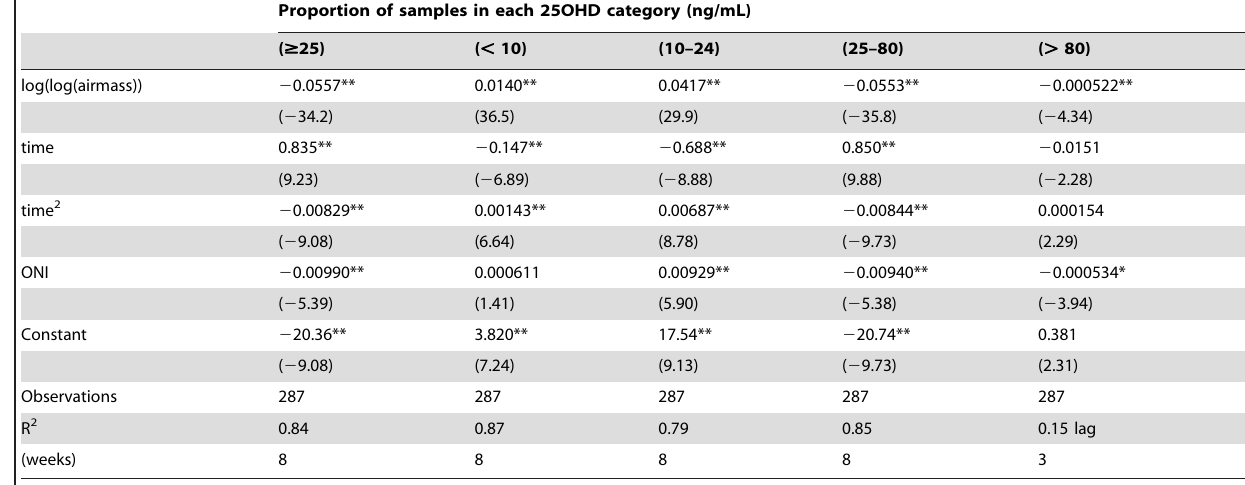
Table 3. Models of categories of 25OHD serum